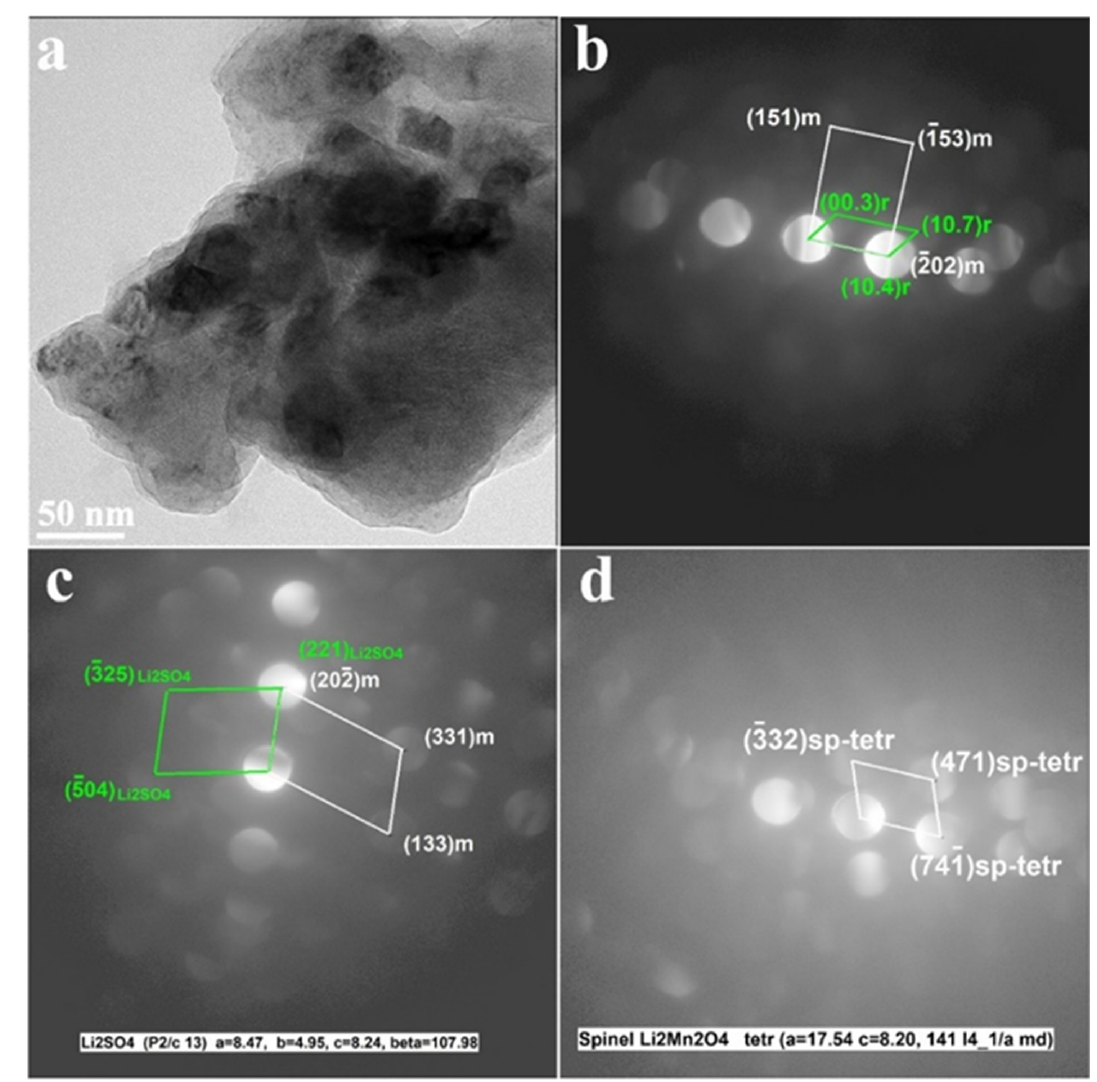
Figure 9. Results of the TEM studies of the Li 2 SO 4 -treated HE-NCM samples cycled in Li cells (after 101 cycles). ( a ) TEM images show agglomerated particles of cycled HE-NCM; ( b – d ) CBED patterns demonstrate the constituent rhombohedral ( R-3m ) and monoclinic ( C2/m ) phases of HE-NCM along with those of Li 2 SO 4 ( P2 1 /c ) and tetragonal spinel-type (marked sp-tetr) in Figure 9c,d, respectively. The latter was formed during cycling because of a partial layered-to-spinel structural transformation.